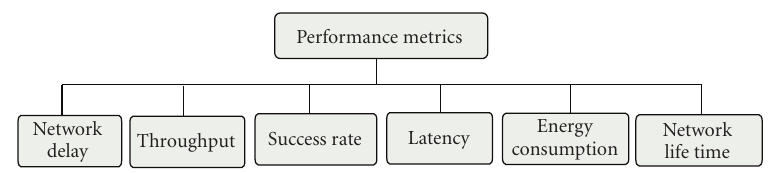
Figure 2: A set of performance